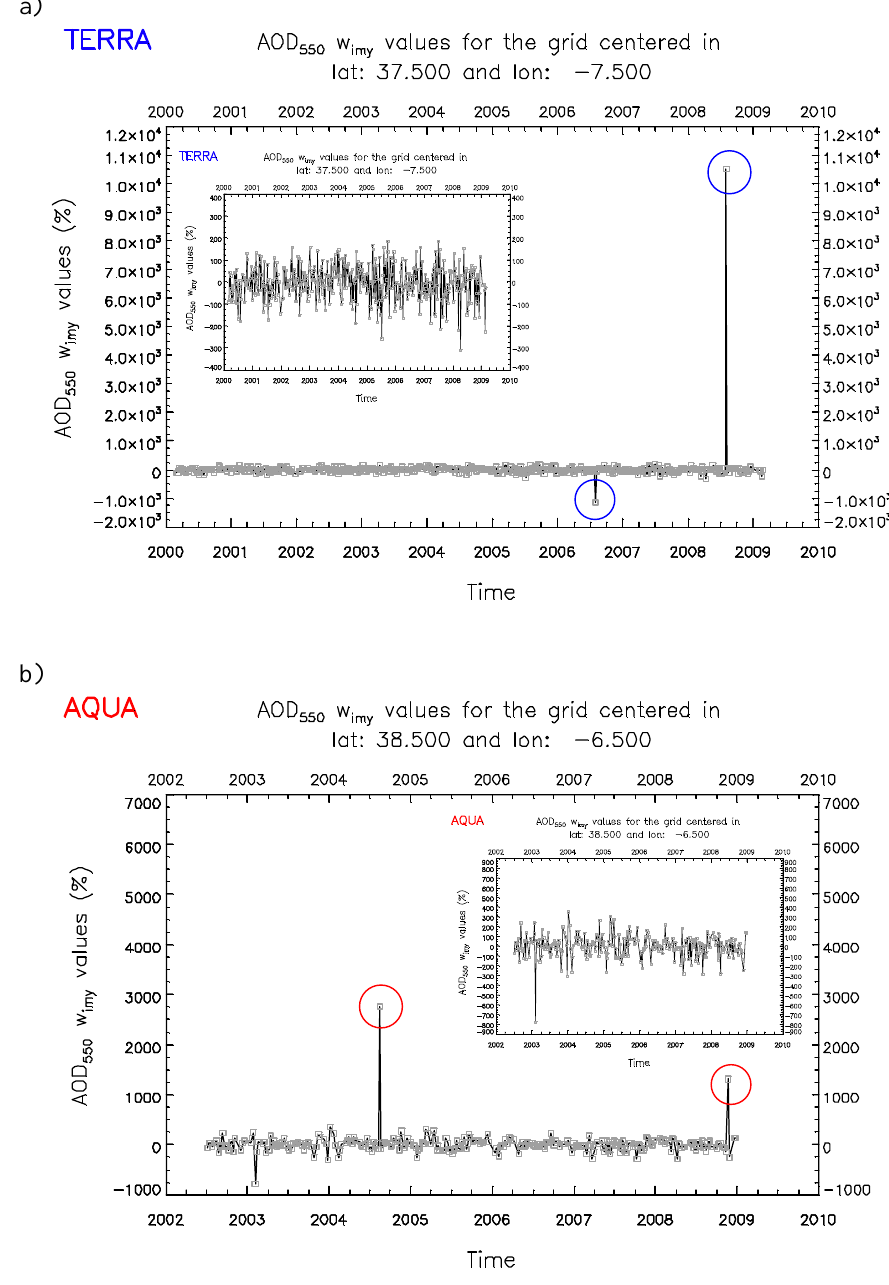
Fig. 2. w imy time series before (big panel) and after (small panel) the application of the ± 1000% limit correction for (a) TERRA MODIS AOD 550 measurements for the grid cell centered in (37.5 ◦ N, 7.5 ◦ W), (b) AQUA MODIS AOD 550 measurements for the grid cell centered in (38.5 ◦ N, 6.5 ◦ W). In both figures the values that exceed the ± 1000% limit are encircled.